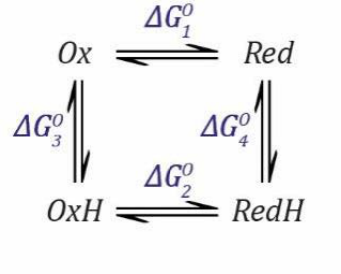
Scheme 2. Scheme showing the free energy changes for the reactions in a simple proton